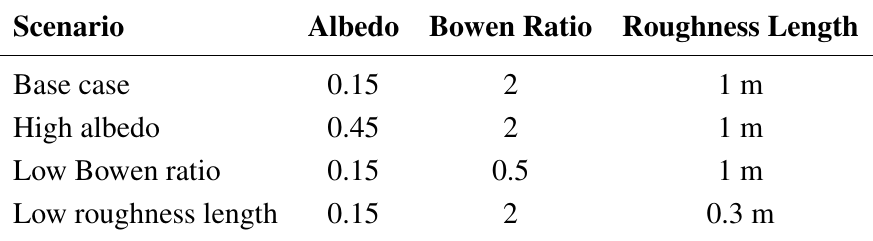
Table 2. Values of land use